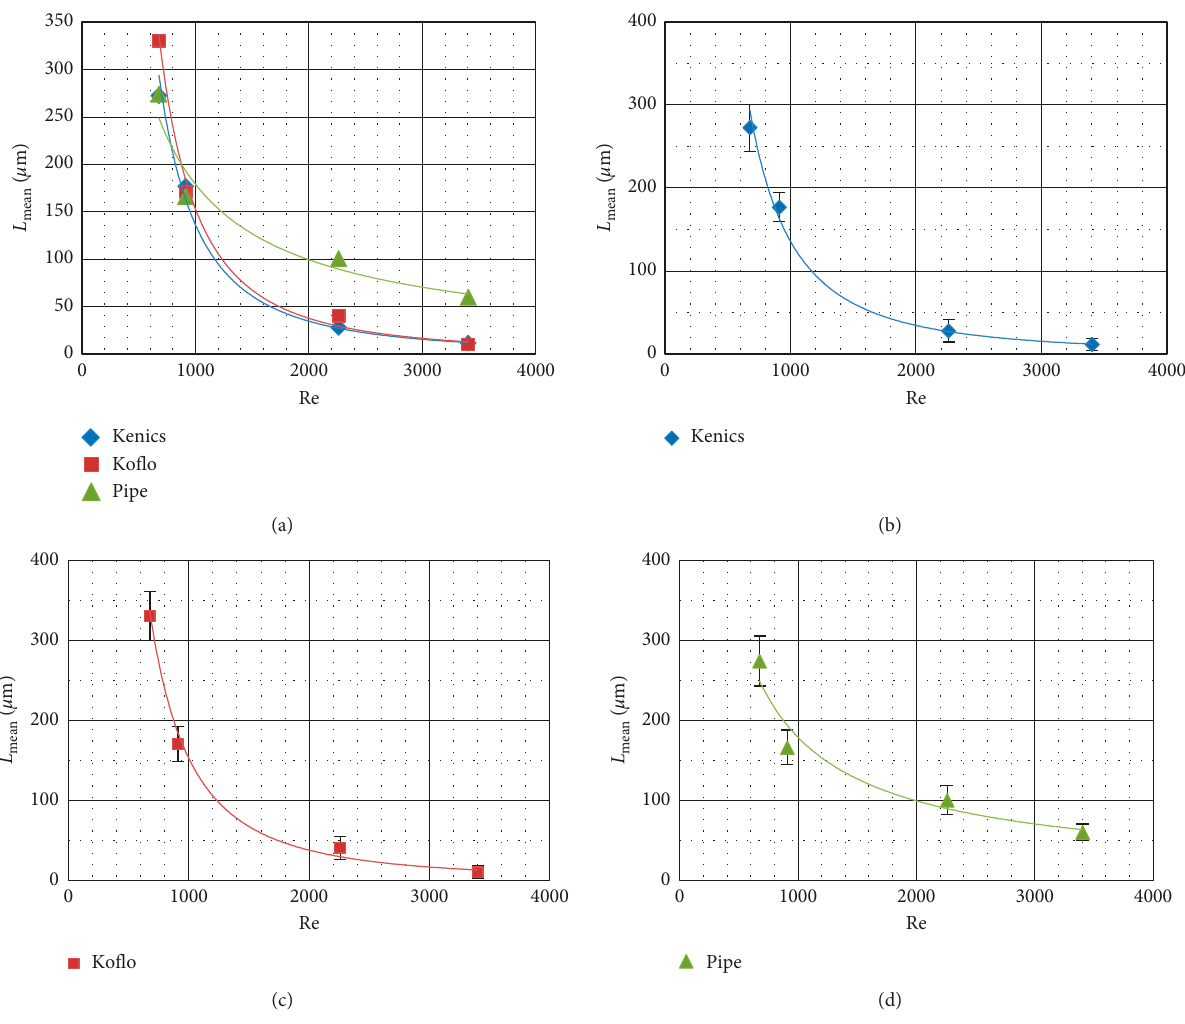
Figure 16: (a) The effect of the Reynolds number on the mean crystal size: plots with scatter bars showing the standard deviations from the mean crystal size of (b) Kenics, (c) Koflo, and (d)